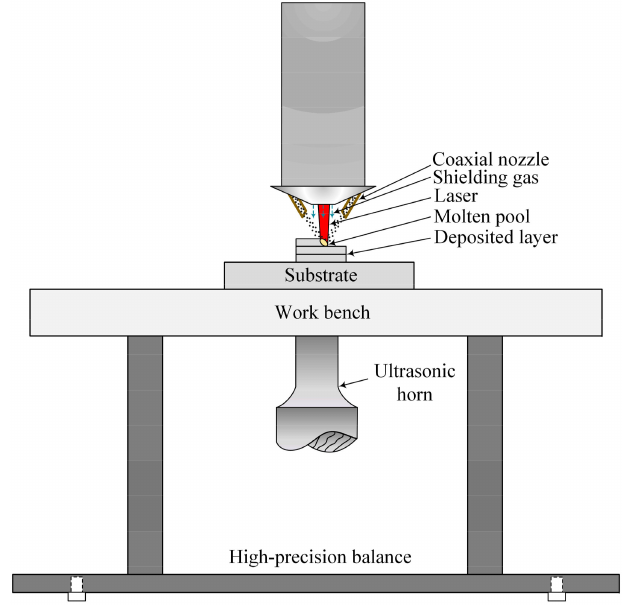
Figure 1. Schematic of ultrasonic-assisted laser metal deposition.